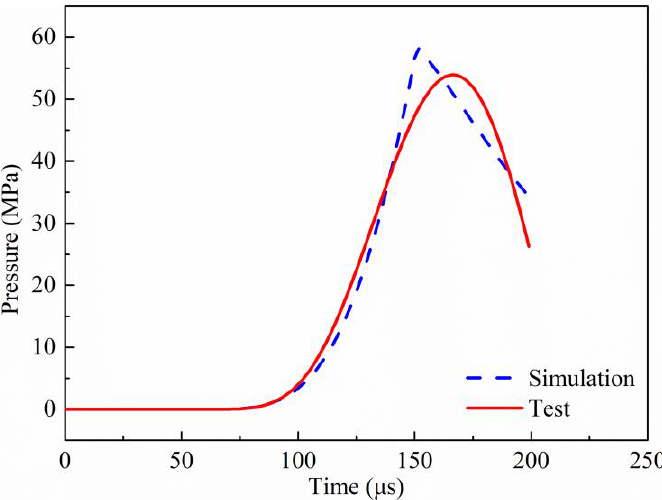
Figure 5. Comparison between simulation and experiment. Table 2. Comparison of features between simulation and experiment.